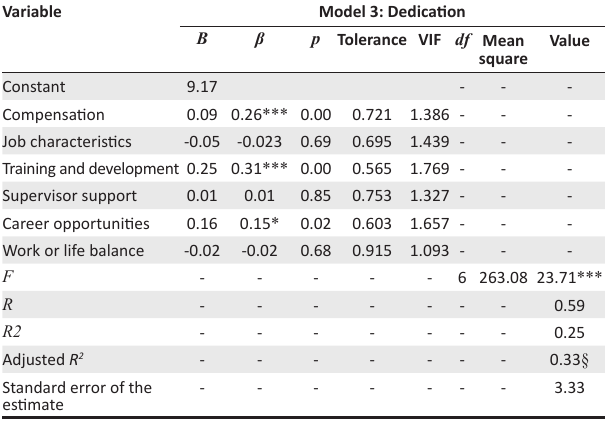
TABLE 6: Multiple regression analysis: Retention Factors Measurement Scale as a predictor of dedication ( N = 278).